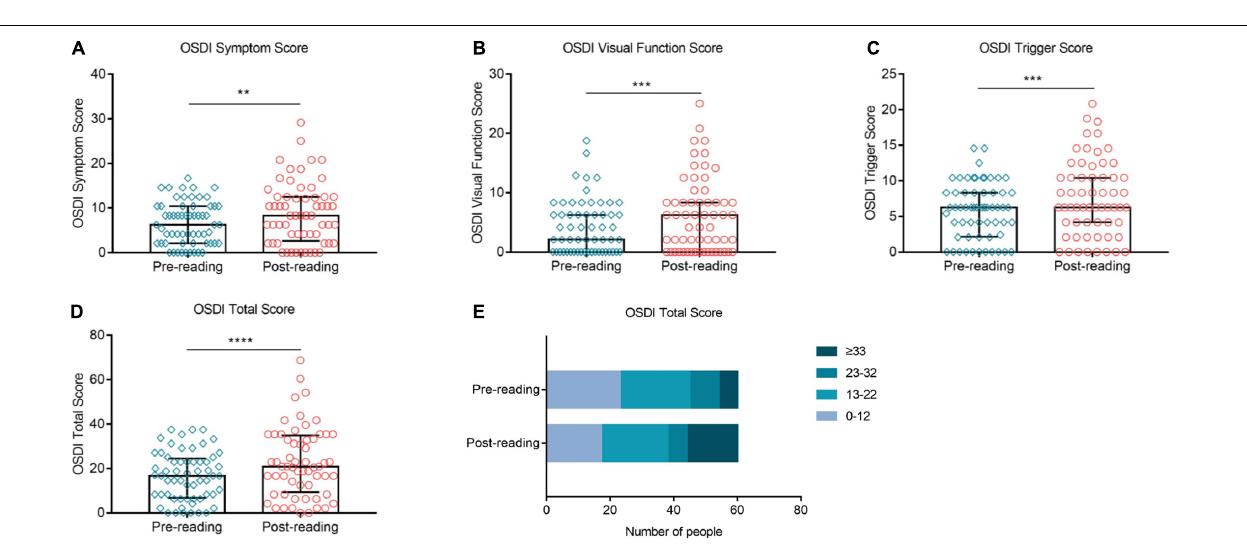
FIGURE 6 | Effects of continuous smartphone reading for 2 h on CFS, MG expressibility and MG quality. No significant difference was observed in CFS (A,B) , MG expressibility (C) and MG quality (D) between the two groups. (A–C) Dates are presented as median and interquartile range.